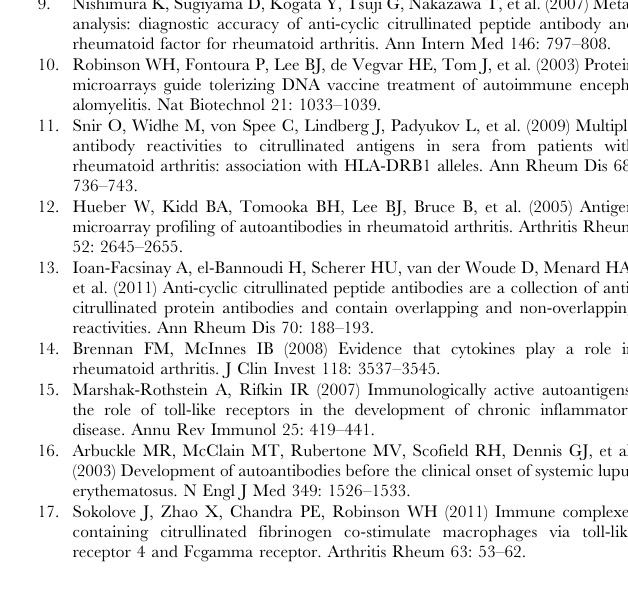
Table S1 List of antigens and cytokines/chemokines analyzed. Final antigen list was selected as described in the methods section. Cytokines/chemokines were evaluated using a commercial 27-plex and 21-plex cytokine/chemokine kit (Bio-Rad Laboratories). For the all predictive analyses only analytes which significantly different between RA cases and healthy matched controls were used for statistical modeling. coefficients of variance (CV) on the BioPlex antigen array platform. To validate the reliability of the novel bead- based antigen array 7-fold intra-assay and 14-fold inter-assay CV was calculated. Figure S1 Heatmap of autoantibody and cytokine levels during the preclinical period in individuals that devel- oped RA. Results from preclinical and post-diagnosis serum specimens were binned by timepoints relative to the time of diagnosis of clinical RA, and the matched samples from health controls binned binned in a parallel manner. Results are expressed as *Z-normalized values for each biomarker, and the scalebar represents Z-normalized value. *Z-normalized values represent the number of standard deviations above or the below the mean level observed in control subjects for each cytokine or autoantibody.